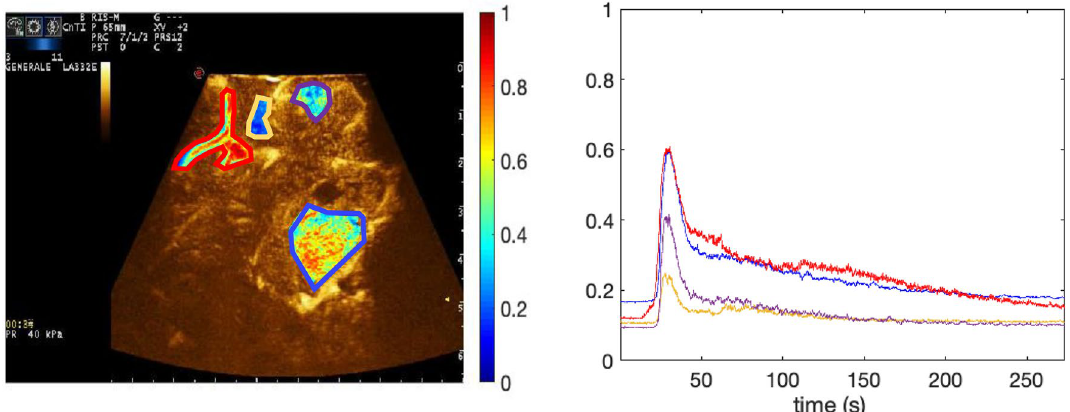
Figure 2. Time Intensity curves to show the microbubble distribution of distinct brain structures over time. Displays the extracted intensity values from each ROI over the microbubble life cycle in a patient diagnosed with a mesial temporal lobe high grade glioma. The quantified time-intensity curves show each selected structure of the brain over 1696 frames sampled at 20 Hz, approximately an 85 s timespan. The x-axis displays time in seconds over the duration of the 85 s video. Each intensity value is equivalent to the average intensity of a given ROI for each frame, or in time the average of every 0.05 s. Qualitatively, the four ROI’s show differences in distribution, with the artery and tumor structures showing the higher microbubble density, compared to white and grey matter.